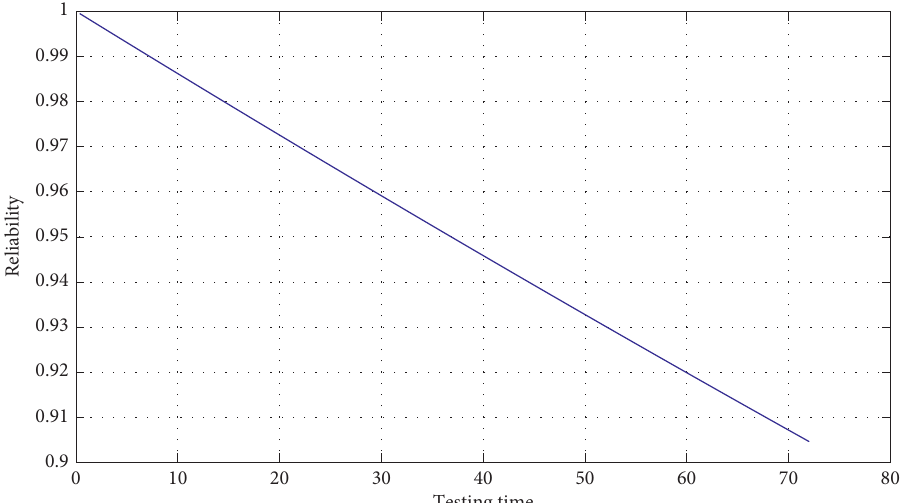
Figure 13: Reliability curve of aging test stage.